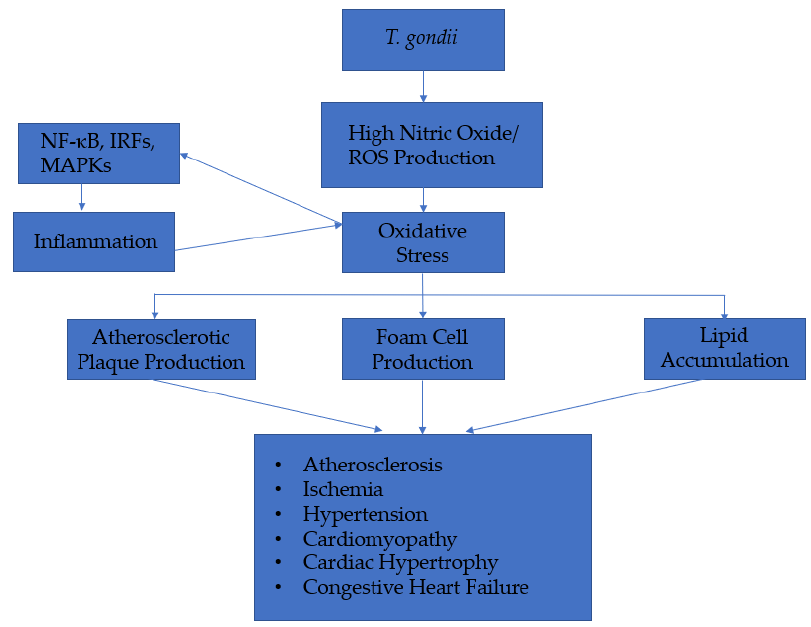
Figure 2. Mechanism of action of T. gondii on cardiovascular-related dysfunction.